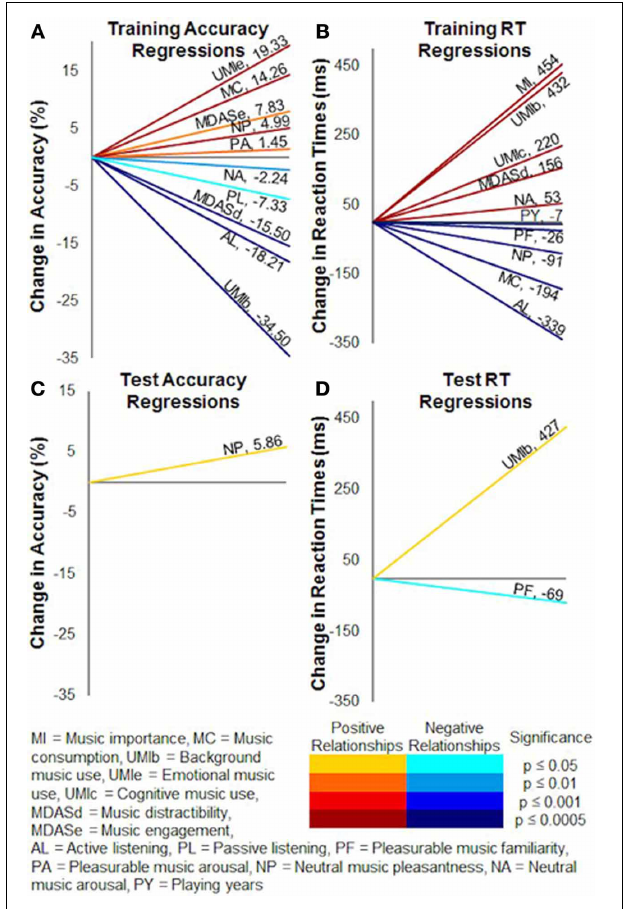
FIGURE 9 | Multiple regression correlations on training and test accuracy and reaction times. Multiple linear regressions revealed many individual factors significantly correlated to probabilistic selection task performance. (A) Training accuracy. (B) Training reaction times. (C) Test accuracy. (D) Test reaction times. Numerical values show the slopes of the regressions, and colors represent the directions and significance levels of the